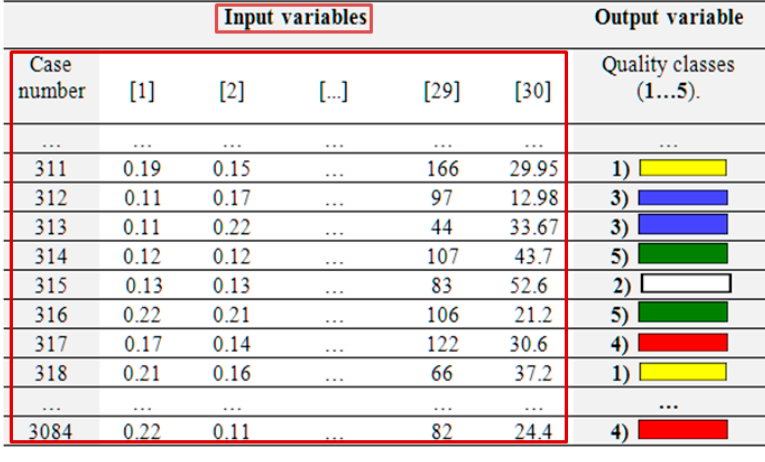
Figure 4. A fragment of the training file.